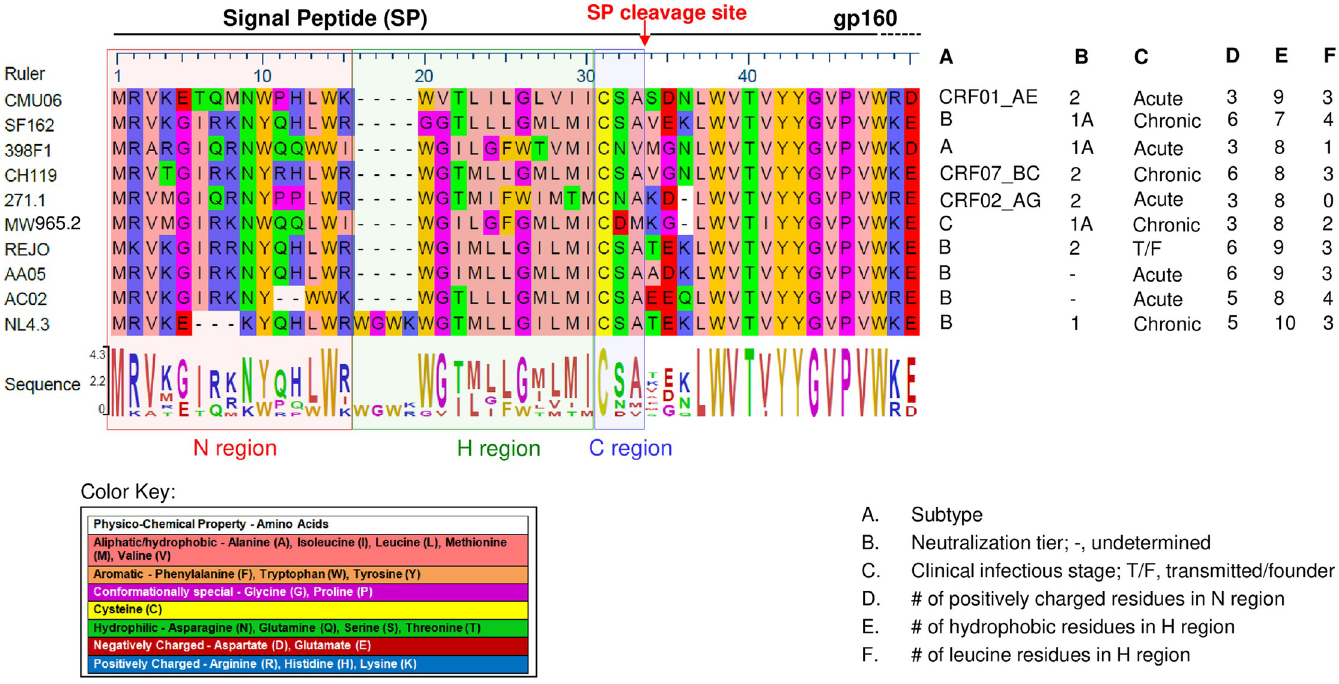
Fig 1. Sequence alignment of all Env SPs tested in this study. Amino acid sequence alignment was performed using the Lasergene DNASTAR Megalign software. Dashes (-) indicate missing residues.